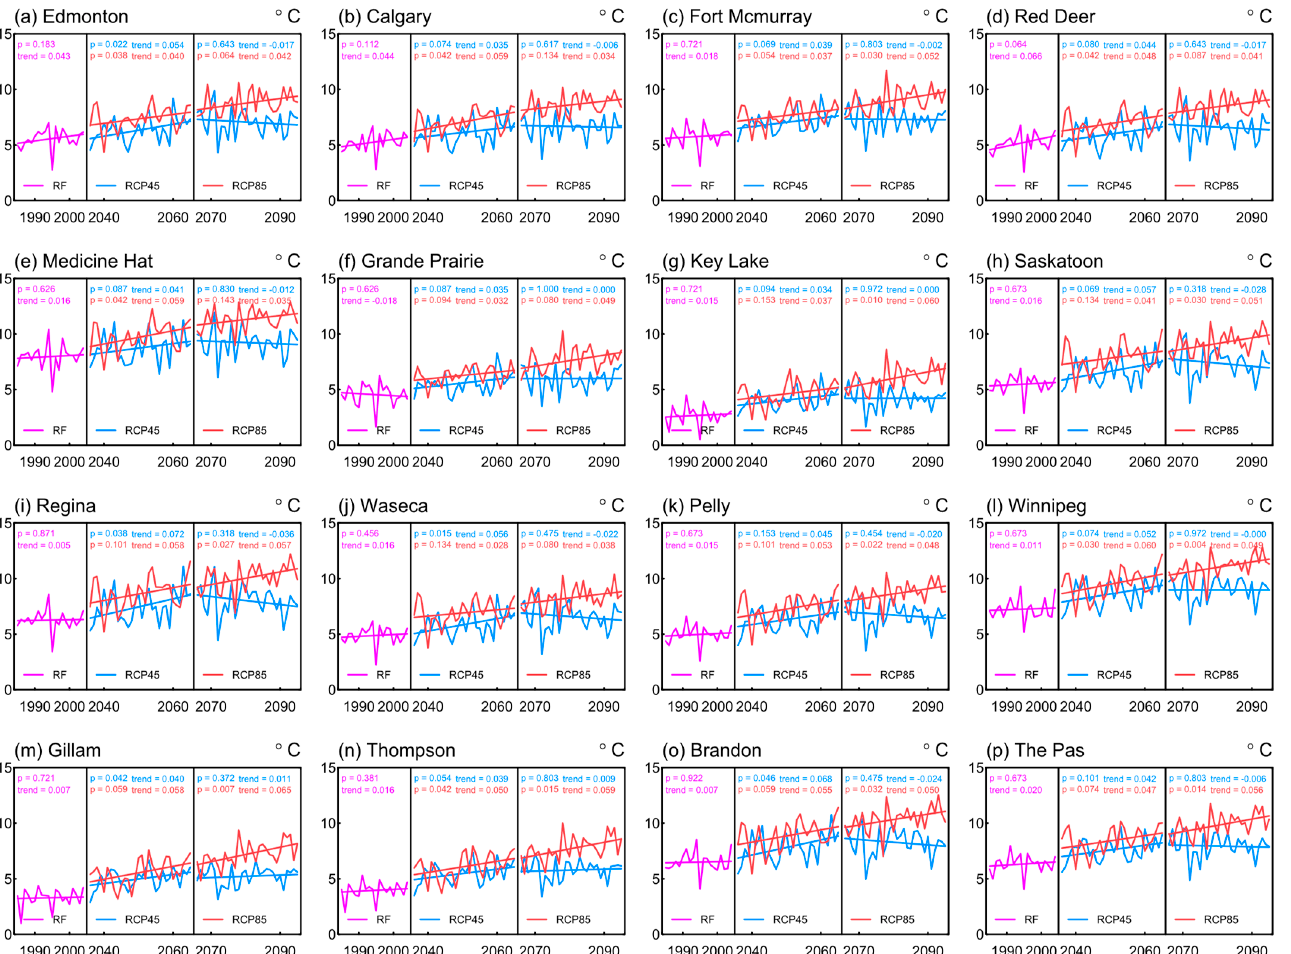
Figure 10. Temporal trends in annual averages of T max at the 16 stations. The value of p and trend is derived from the MK test and the Theil–Sen estimator, respectively. The straight line represents the linear trend derived from the Theil–Sen estimator. ( a ) Edmonton, ( b ) Calgary, ( c ) Fort Mcmurray, ( d ) Red Deer, ( e ) Medicine Hat, ( f ) Grande Prairie, ( g ) Key Lake, ( h ) Saskatoon, ( i ) Regina, ( j ) Waseca, ( k ) Pelly, ( l ) Winnipeg, ( m ) Gillam, ( n ) Thompson, ( o ) Brandon, and ( p ) The Pas.